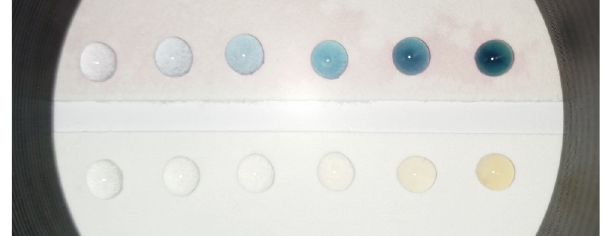
Figure 3 Measurement of plasma samples containing active butyrylcholinesterase. The photograph is an unpublished part of cited experiment [65] . The upper line contains saline solution diluted plasma samples and paper containing indoxylacetate, the lower part contains the same samples on a clean cut of paper. The photograph was taken by a smartphone camera and served for color depth determination when the photograph underwent image